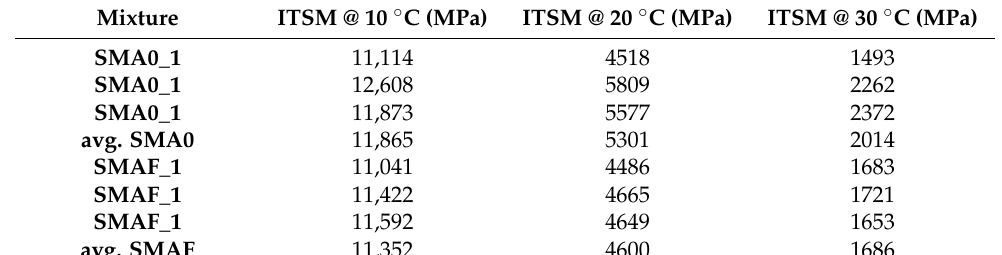
Table 7. Indirect tensile stiffness modulus results.